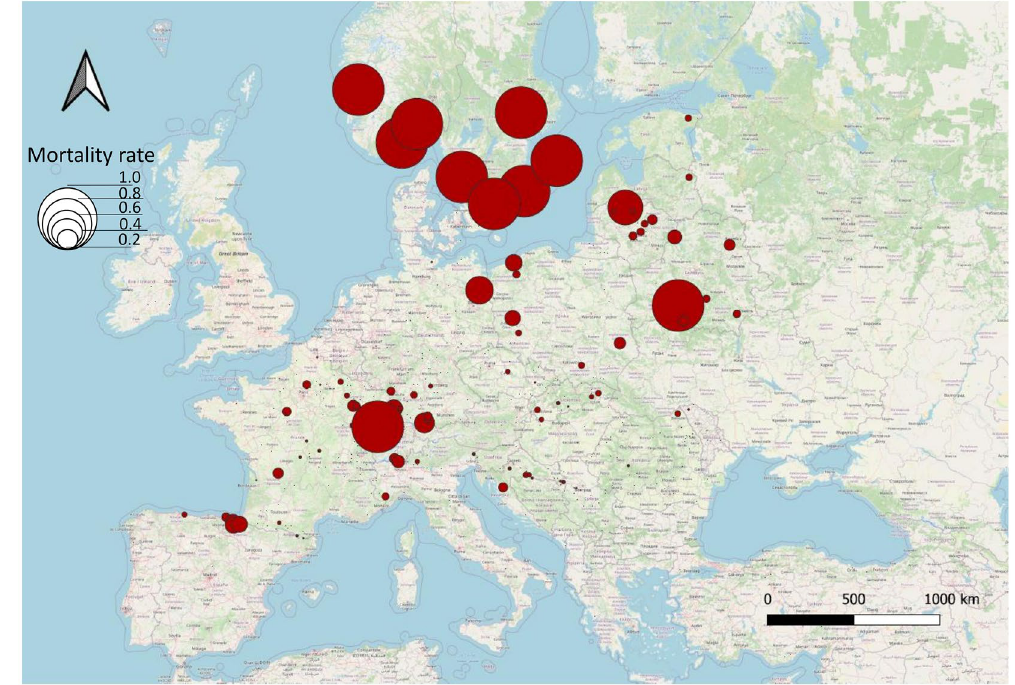
Figure 2. Cummulative mortality rate of ash between 1987 and 2020.